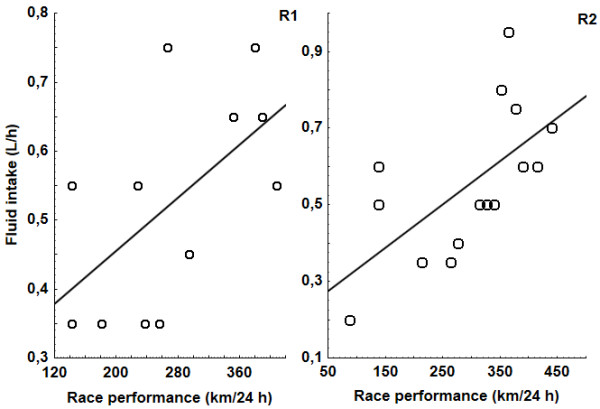
Fluid intake was positively related to race performance (R1: r = 0.58, p = 0.05; R2: r = 0.63, p = 0.01). R1: Czech Championship 24-hour MTB race‘ in Jihlava city, 24-hour MTB race, R2: ,Bike Race Marathon Rohozec 24 hours‘ in Liberec city, 24-hour MTB race.